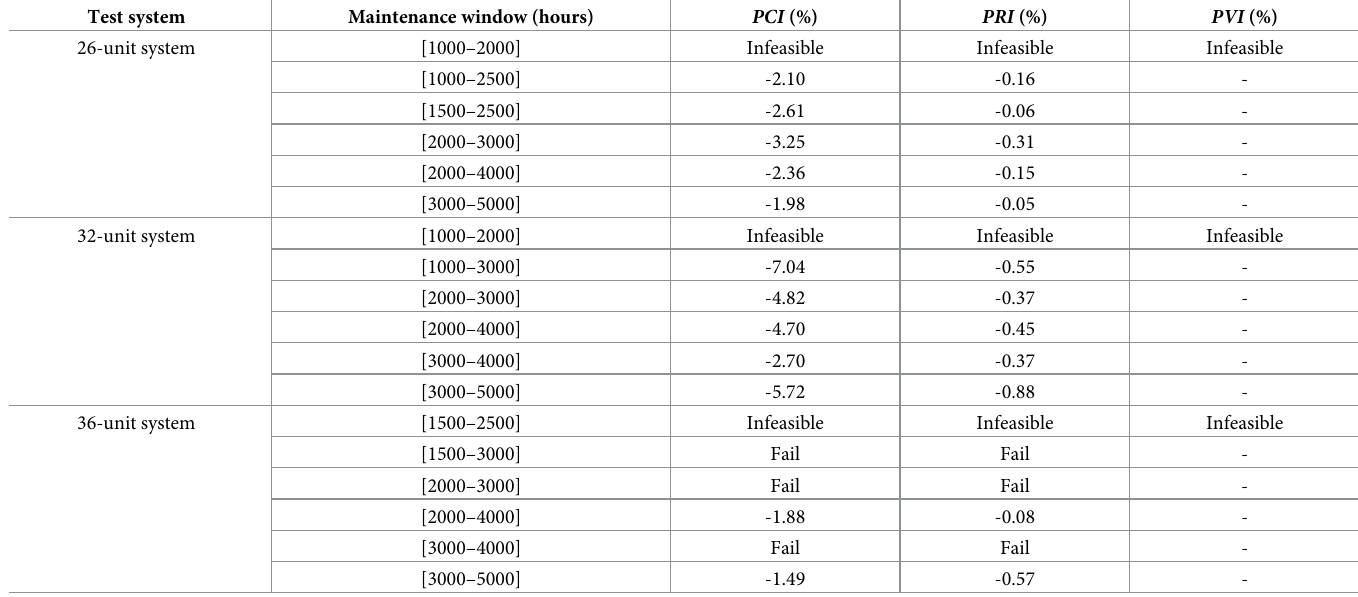
Table 11. Percentage of cost, and gross reserve improvements between GMS model II and the basic GMS model I. Test system